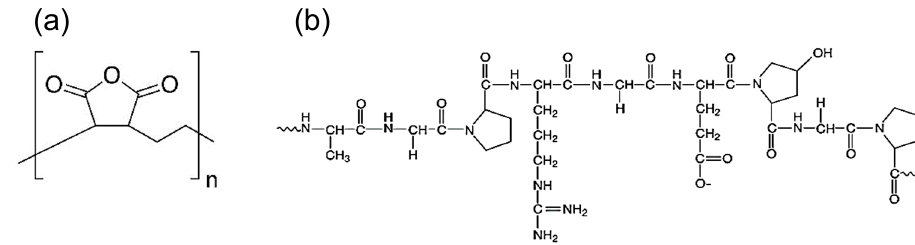
Figure 1. Chemical structures for ( a ) PEMA and ( b ) GEL.